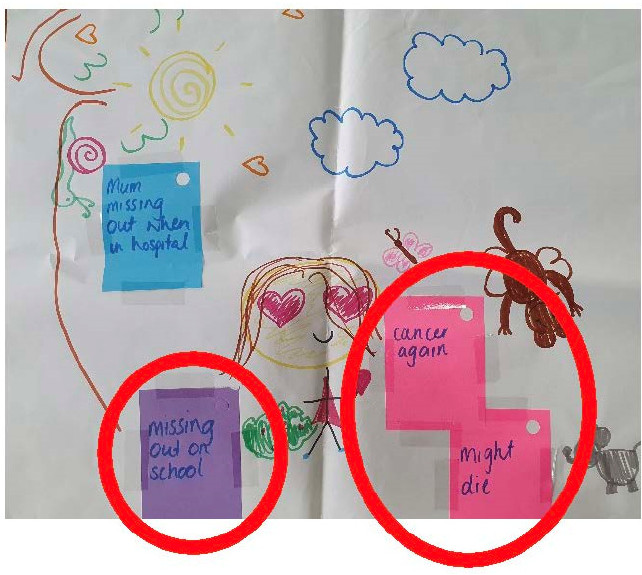
Figure 2. Child’s self-portrait and relative worries (Indigo; female: 8 years). Children’s worries tended to be ongoing, and their level of intrusiveness appeared vulnerable to external circumstances such as whether the parent was in hospital or actively receiving treatment. For example, one child discussed her experience of an activity facili- tated by an arts therapist who had been engaged by the family. In this activity, she was asked to report her worries and feelings. Her reiteration of this highlighted the chronic nature of her worry and the direct impact her mother’s fluctuating health status had on her levels of